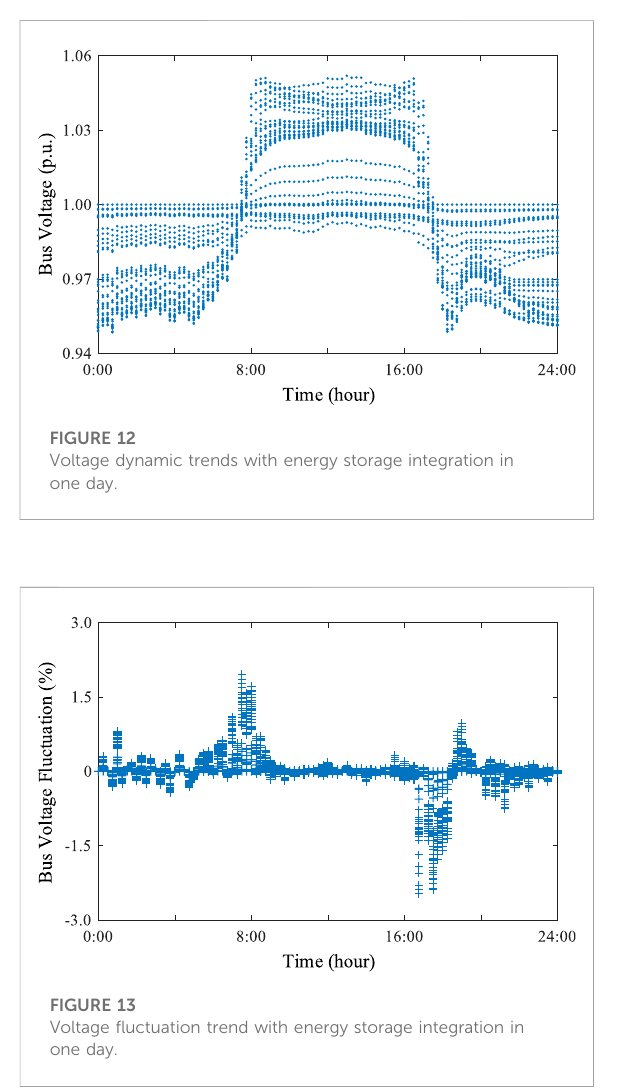
FIGURE 15 Harmonic voltage distortions with energy storage